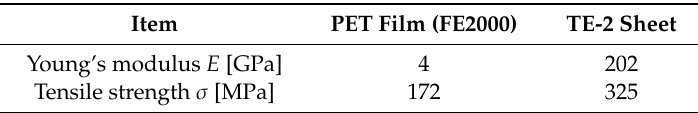
Table 1. Mechanical properties of materials.